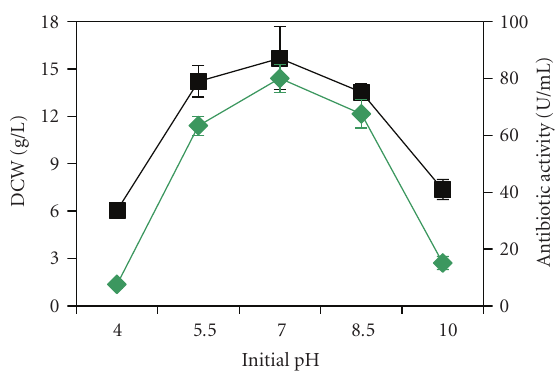
Figure 1: E ff ects of initial pH on dry cell weight (DCW) ( ) after 72h of fermentation with various initial antibiotic activity ( (cid:2) pH in flask shake cultures.